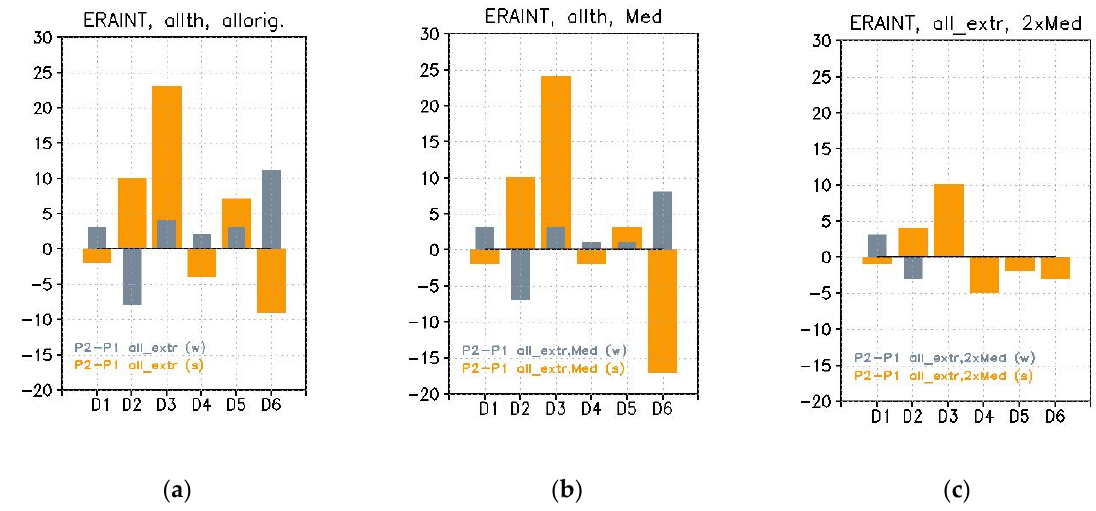
Figure 4. Changes in the number of extreme cyclone tracks (sum over all extreme classes in Table 3) for the three types of origins: “EU” origins ( a ), “Med” origins ( b ), and “2xMed origins ( c ); difference in P2–P1 for winter (gray) and summer (yellow).